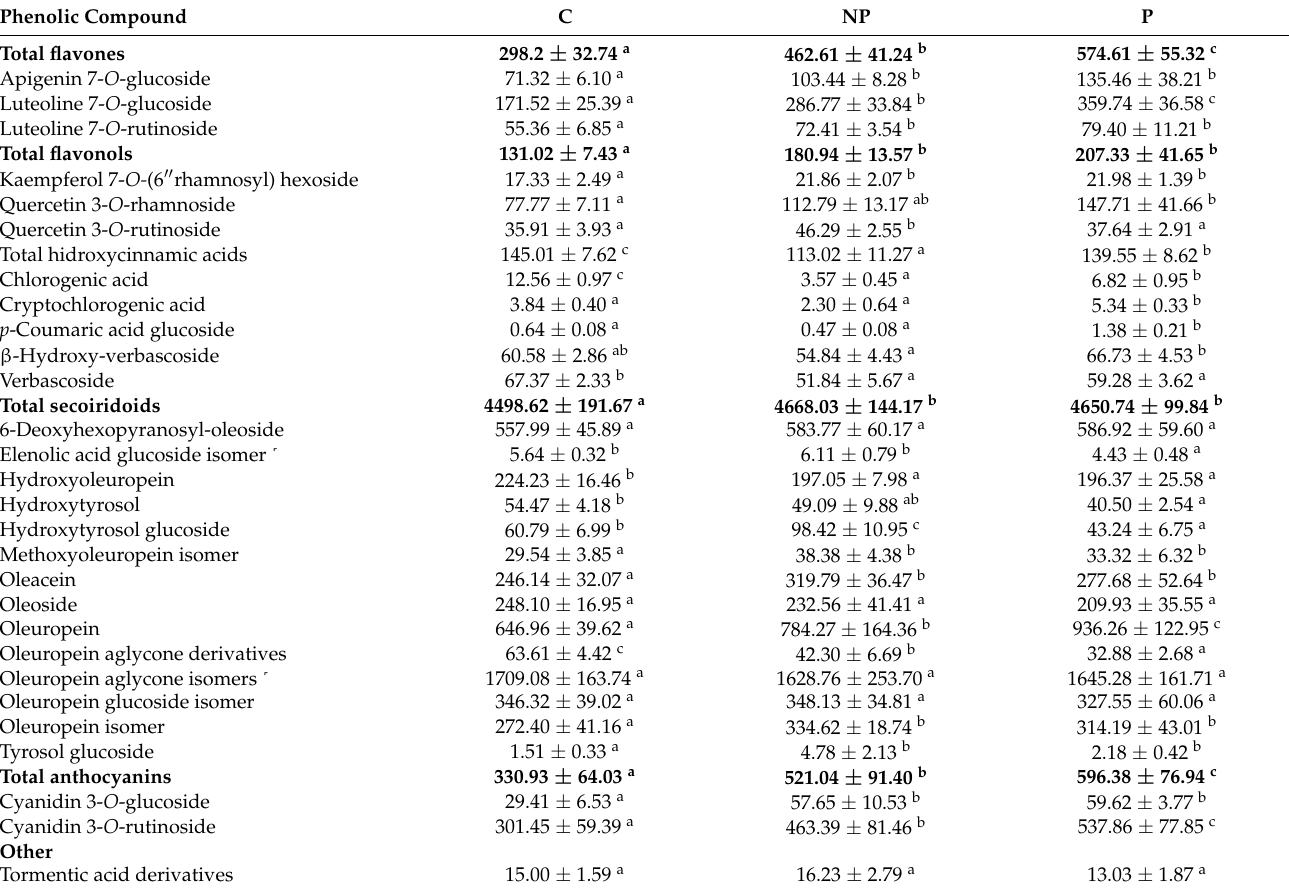
Table 4. Individual phenolic compounds (mg kg − 1 FW) of control fruits, pierced tissue of damaged fruits, and non-pierced tissue of damaged fruits in cultivar ‘Pendolino’. Table 3. Individual phenolic compounds (mg kg − 1 FW) of control fruits, pierced tissue of damaged fruits, and non-pierced tissue of damaged fruits in cultivar ‘Istrska belica’.